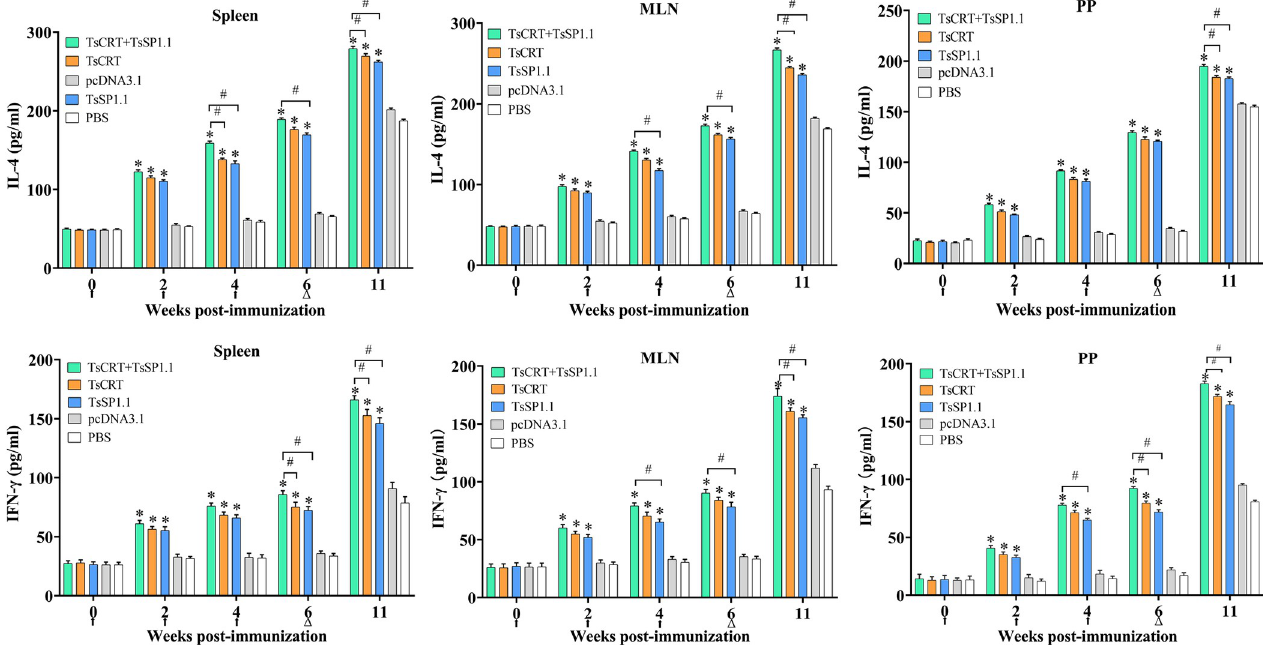
Fig 9. Cytokines secreted by spleen, mesenteric lymph nodes (MLN) and Peyer’s patches (PP) from mice immunized with TsCRT+TsSP1.1, TsCRT or TsSP1.1 at different times after immunization. Concentrations of two cytokines (IFN- γ and IL-4) were measured in supernatant after the spleen, MLN and PP cells were stimulated with 2 μ g of ML soluble crude antigens for 72 h at 37˚C and 5% CO 2 . The data are shown as the mean ± SD of five mice per group. The vaccination times are shown with arrows ( " ) and the challenge time is indicated by triangles ( Δ ). � P < 0.001 compared to the PBS control groups. # P < 0.05 compared among various vaccination groups.